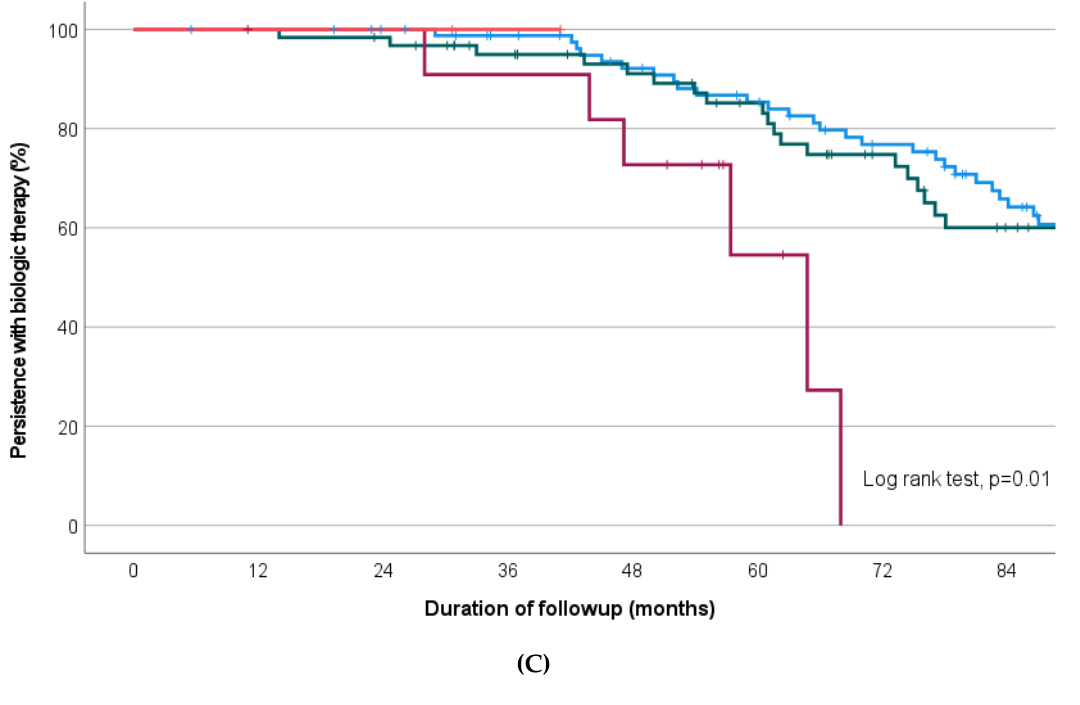
Figure 3. Kaplan–Meier survival curves depicting proportion of treatment persistence on biologic therapy during follow-up period comparing ( A ) Anti-TNF therapy as first biologic, then anti-TNF therapy second (blue line) versus anti-TNF therapy first then non-anti-TNF therapy second (green line), ( B ) Anti-TNF therapy first (blue) versus non-anti-TNF therapy first (green) (regardless of second/third biologic thereafter), ( C ) All possible permutations for biologic 1 and 2 sequentially (Blue: anti-TNF therapy first and second-line, Green: anti-TNF first with non-anti-TNF agent second-line (black), Maroon: Non-anti-TNF first with anti-TNF second-line, Red: Non-anti-TNF agent first and second (limited numbers only).